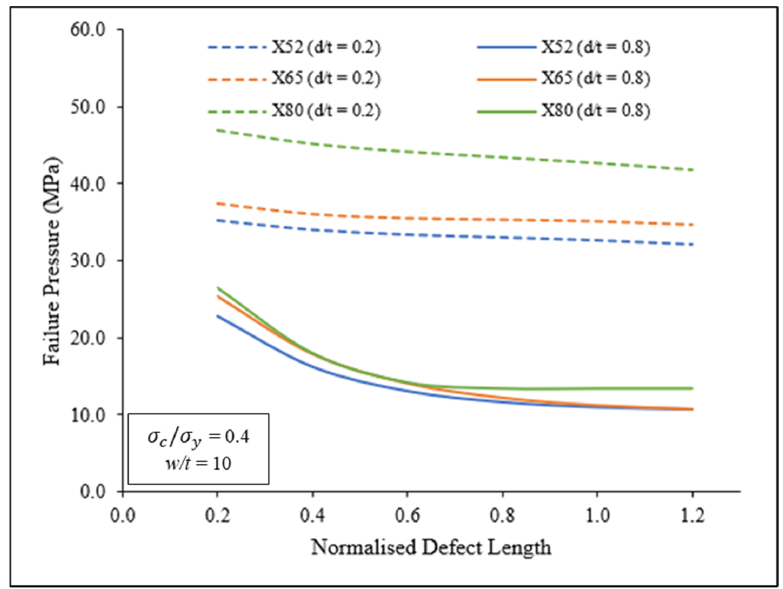
Figure 12. Failure pressure against normalised longitudinal compressive stress with 0.2 and 1.2 normalised defect lengths for X52, X65, and X80.